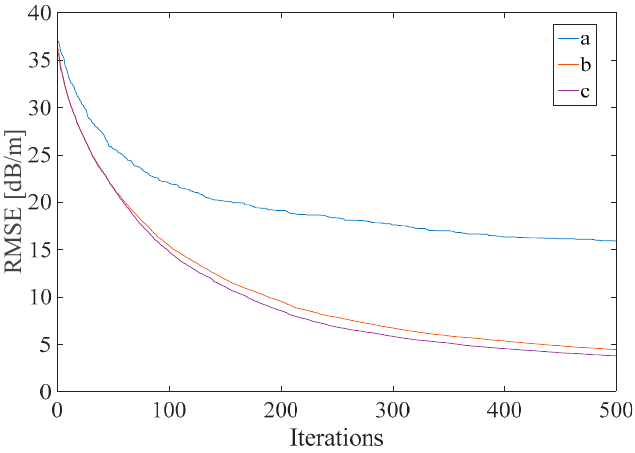
Figure 7. Average of RMSE for these three algorithms according to the multiple tests; curve a is the average RMSE of the SGA; curve b is the average RMSE of the AMPGA; curve c is the average RMSE of the AMPGA with constraints.